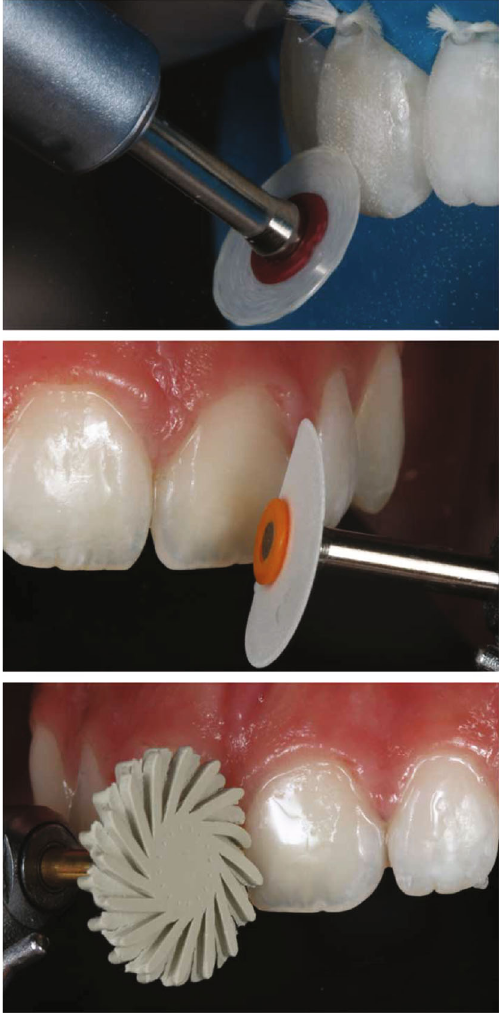
Figure 8: Resin fi nishing and polishing with discs (OptiDisc, Kerr) and resin rubbers (Jota do Brasil).